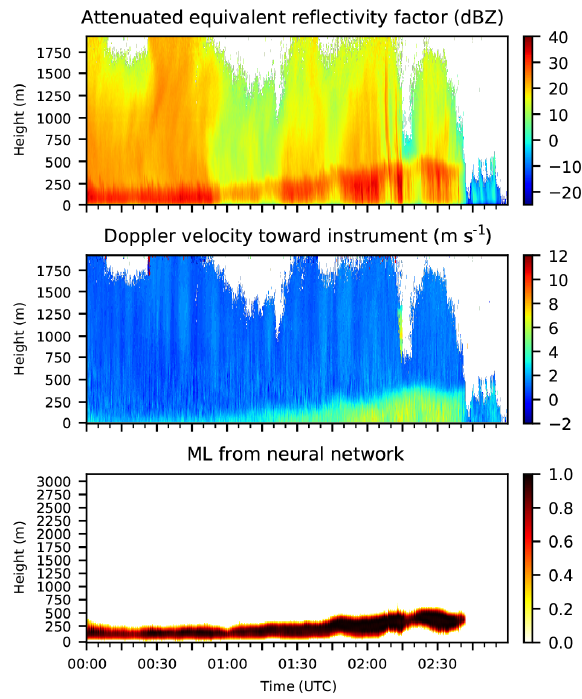
Figure 5. Same as Fig. 4 but for Hohenpeißenberg on 18 November 2018 from 18:00 to 21:00UTC. Figure 6. Same as Fig. 4 but for Hamburg on 14 December 2017 from 00:00 to 03:00UTC.